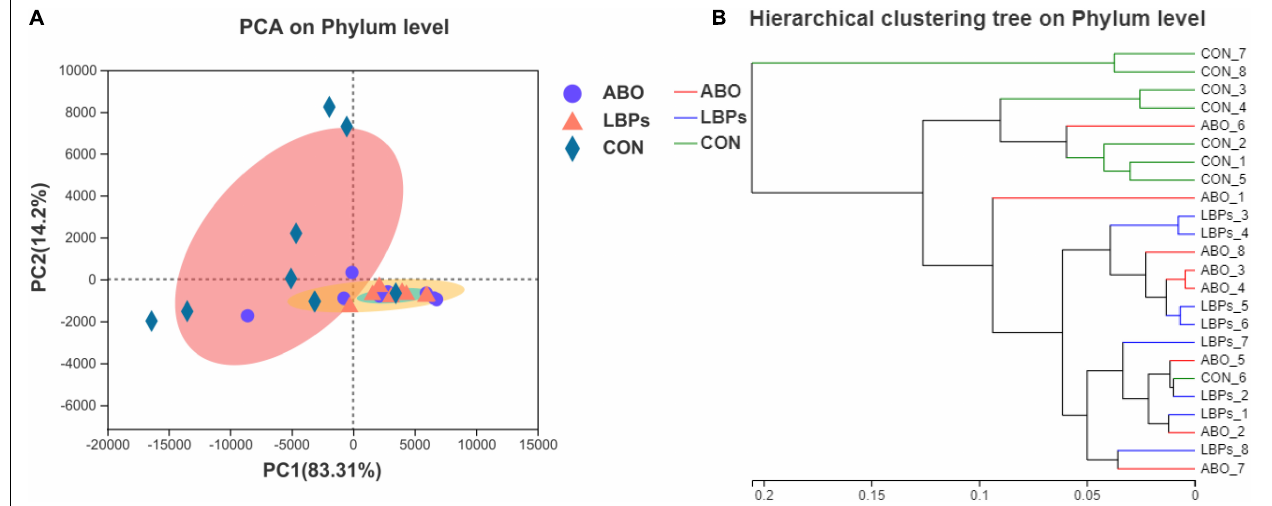
FIGURE 4 | (A) Principal Component Analysis (PCA) of bacterial communities in the cecal digesta of weaned piglets (based on the Bray–Curtis distance) ( n = 8). (B) Analysis of hierarchical clustering tree on Phylun level showed that the microbial composition of CON was almost entirely gathered in another branch. CON, basal diet; LBPs, basal diet + 4,000 mg/kg LBPs; ABO, basal diet + 20 mg/kg flavomycin + 50 mg/kg